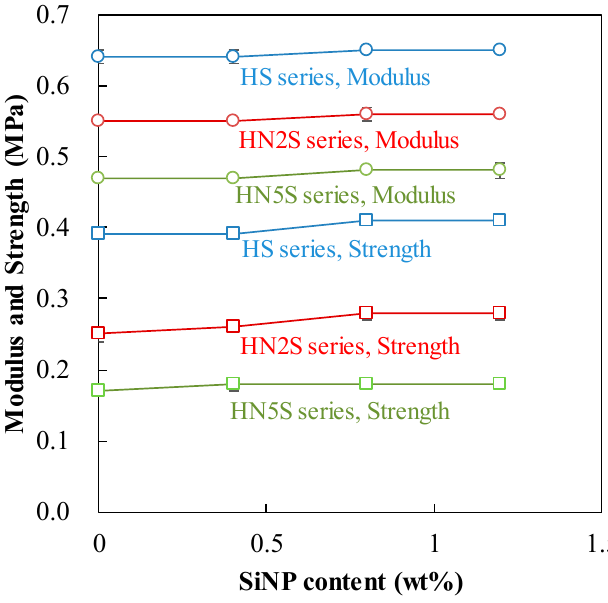
Figure 13. The modulus and strength of SiNPs samples.